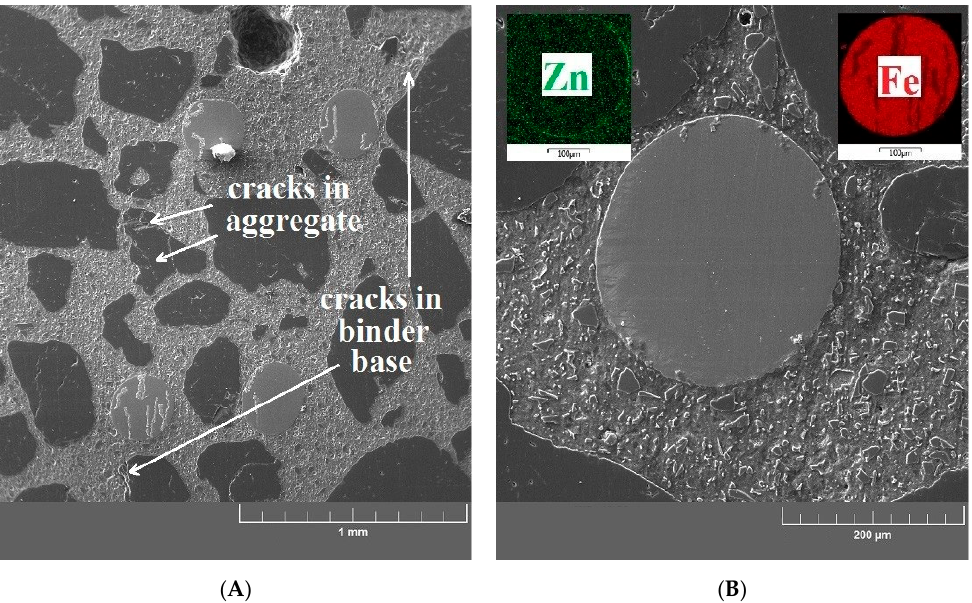
Figure 18. ( A ) SEM image of a sample after exposure to 600 °C focused on the UHPC matrix/aggregate interfacial transition zone. ( B ) SEM image of a sample after exposure to 600 °C focused on the brass-coated steel fiber/UHPC matrix interfacial transition zone.